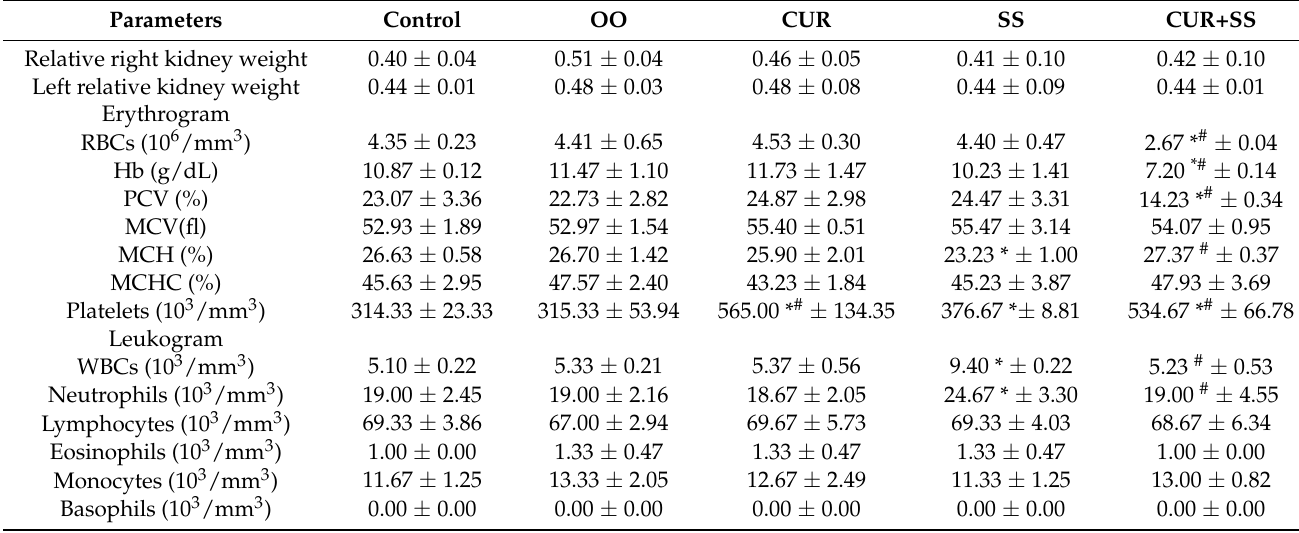
OO: olive oil. Values are represented as the mean ± SD. n = 10 replicates/treatment. * Significantly different compared to the control groups at p < 0.05. # Significantly different from the SS-treated group at p <